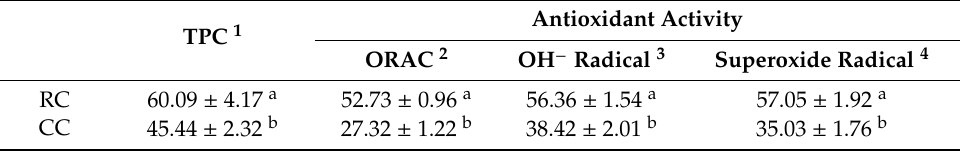
Table 2. Antioxidant properties of raw (RC) and cooked (CC) chickpea.